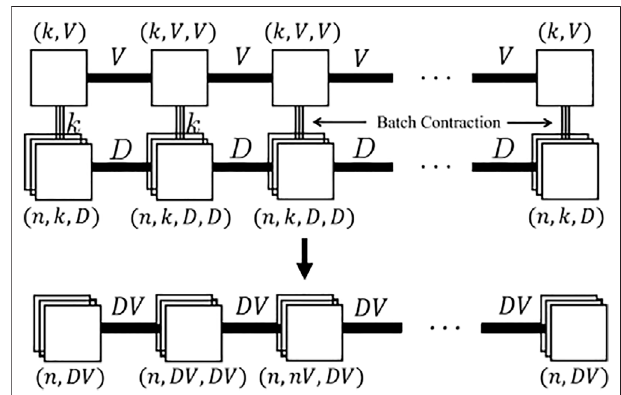
FIGURE7| Illustrationofef fi cientcodingfortheMPS.Eachunitfromthe core MPS is batch-contracted with the input MPS (upper), and they form a batched unit as a local tensor in the resulting MPS